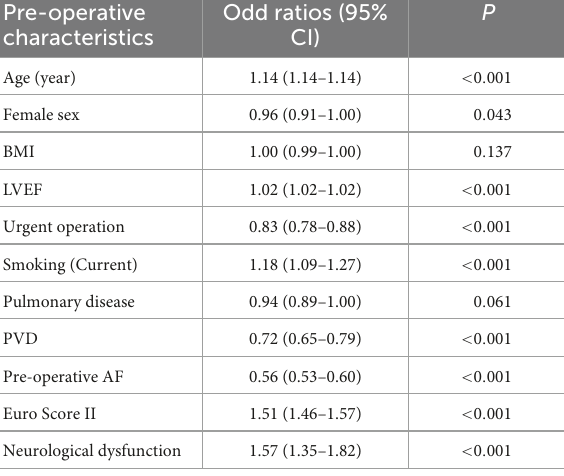
TABLE 2 Intra- and post-operative outcomes of patients < 65 years old receiving biological or mechanical prostheses.